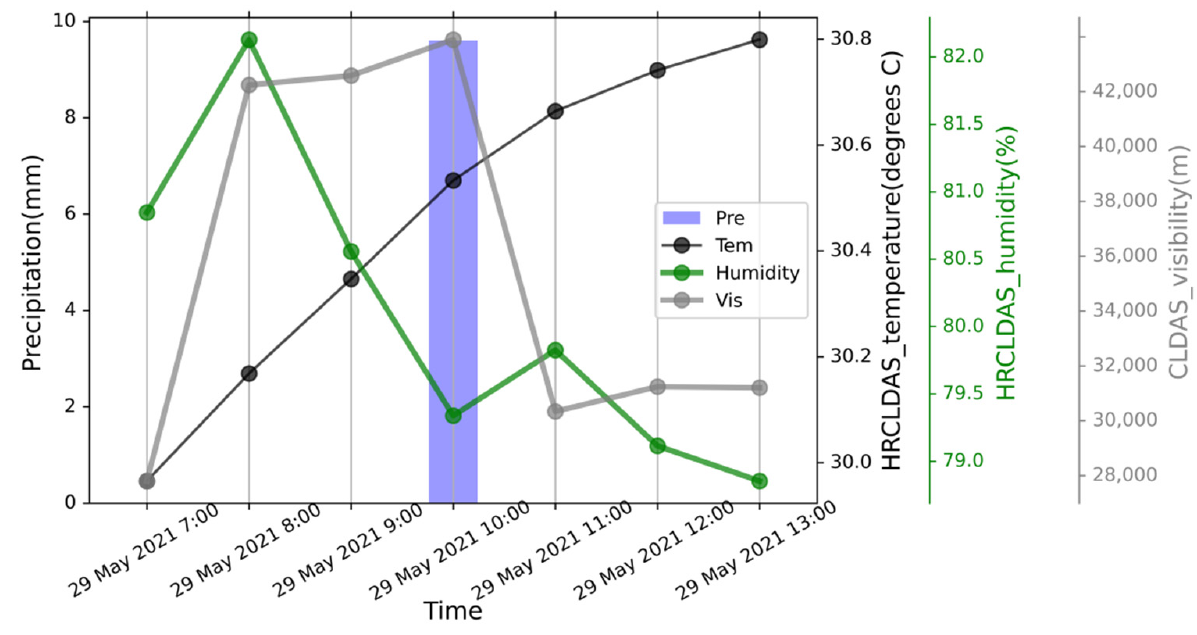
Figure 8. Time series of the weather components of the AWS M0307.